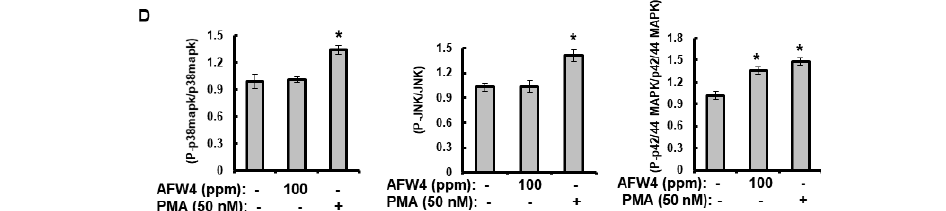
Figure 5. Effects of AFW4 on cell proliferation and skin hydration are mediated by activating p44/42 MAPK. ( A – C ) HaCaT cells were co-transfected with the AP-1-, NF- κ B-, or CRE-promoter-luciferase reporters and β -galactosidase reporter vector using polyethylenimine. After 24 h, the transfected cells were incubated with AFW4, phorbol 12-myristate 13-acetate (PMA), tumor necrosis factor (TNF)- α or forskolin (Fk). Twenty-four hours after the incubation, the cells were harvested and subjected to luciferase reporter assay. ( D ) Cells were incubated with AFW4 or PMA for 1 h. The cells were harvested immediately after the incubation, and the protein levels of MAPKs and their phosphorylated forms were detected by ELISA. The results were confirmed using four independent experiments. Each experiment was conducted in duplicate. All data are presented as the mean ± SEM of four independent experiments. Statistical significance of differences among the groups was assessed by ANOVA, followed by Tukey’s multiple-comparison test, using the GraphPad Prism 5 software. * p < 0.05 vs. control group.